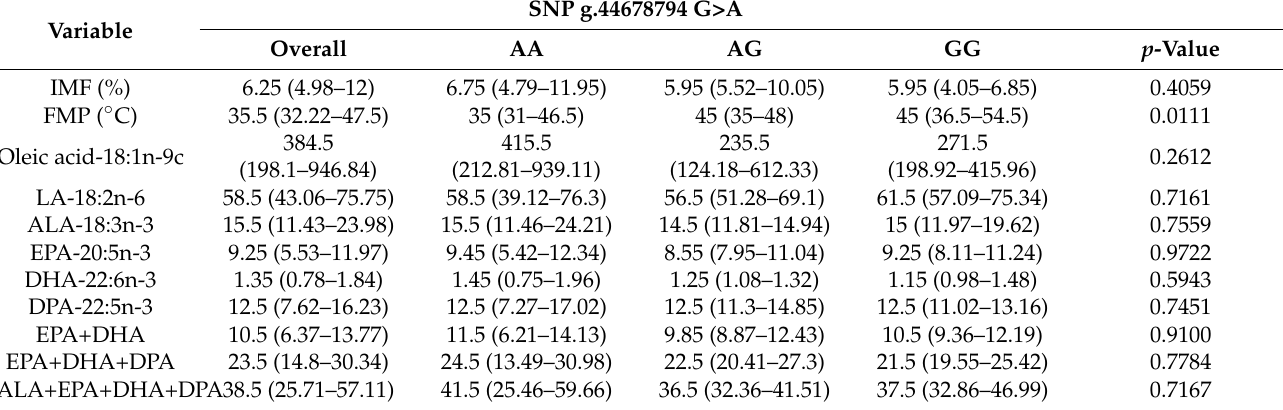
Table 8. Descriptive summaries of the associations between FABP4 SNP locus g.44678794 G>A and genotypes with intramuscular fat (IMF), fat melting point (FMP), and fatty acid composition in Bowen Genetics Forest Pastoral Angus, Hereford, and Wagyu beef cattle presented as median (inter-quartile